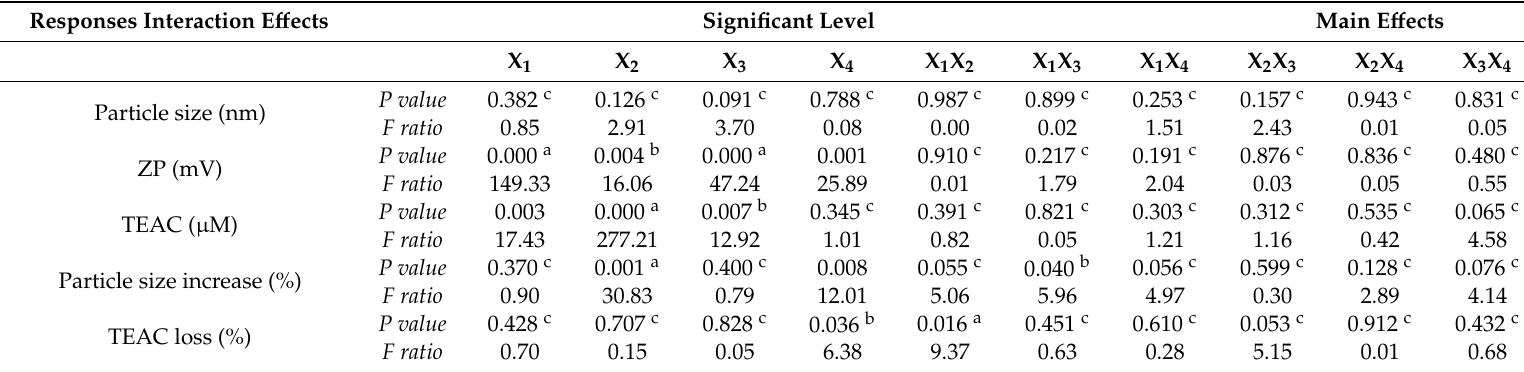
Table 4. Analysis of variance for the experimental variables as main and interaction terms of each response variable and corresponding coe ffi cients fitted for particle size (nm), zeta potential (ZP), trolox equivalent antioxidant capacity (TEAC), particle size increase (%) and trolox equivalent antioxidant capacity (TEAC) loss